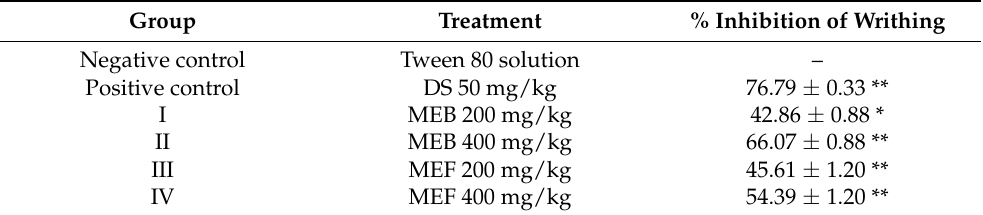
Table 5. Peripheral analgesic effect of methanolic extract of bark (MEB) and methanolic extract of fruit coat (MEF) of W. coccinea in acetic acid-induced abdominal writhing mice. Group Treatment % Inhibition of